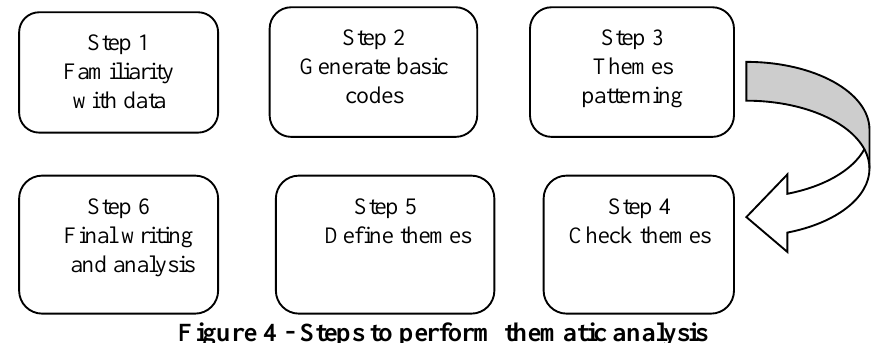
Figure 4 - Steps to perform thematic analysis